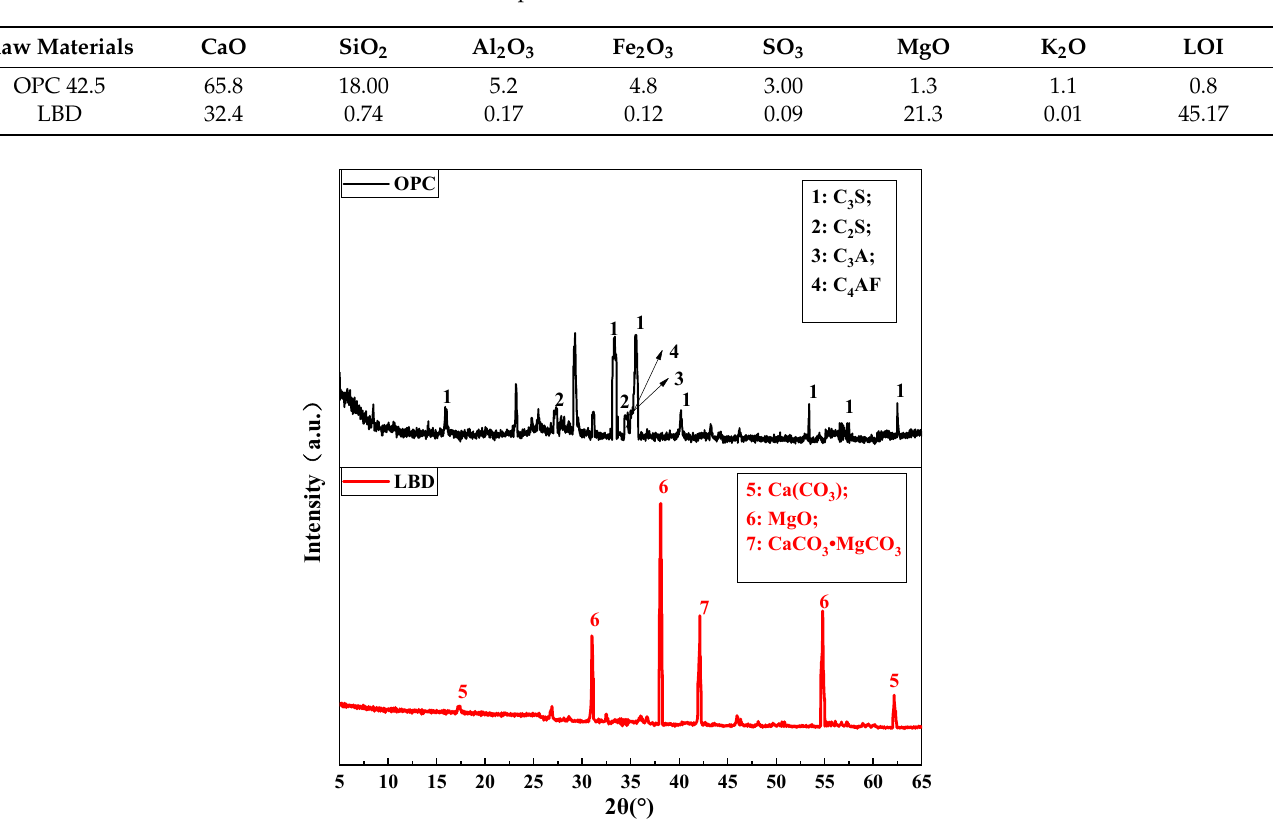
Table 1. Chemical composition of raw materials.